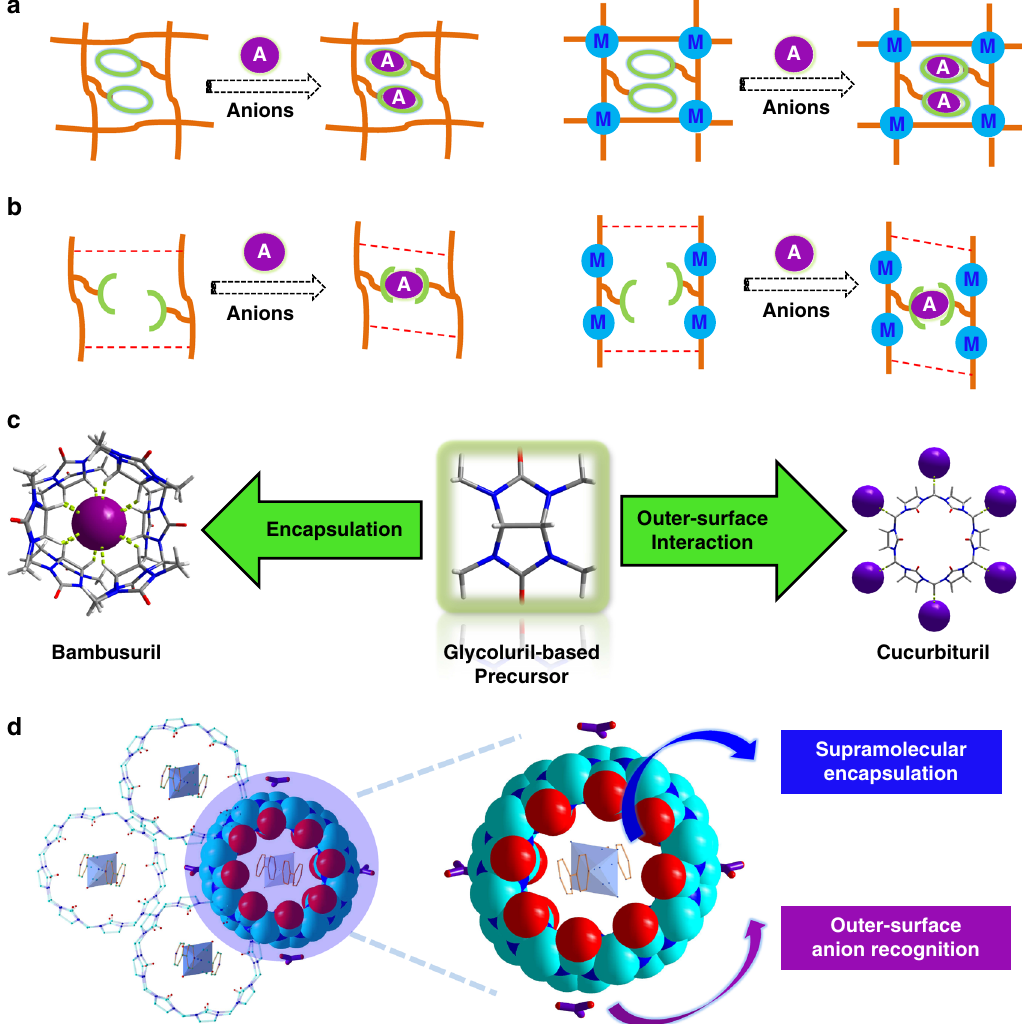
Fig. 1 Design strategies for introducing anion-adaptive capability to sorbent materials. a Direct modi fi cation of organic polymers or metal – organic sorbents with macrocyclic motifs bearing anion-recognition ability (orange lines: backbones of solid sorbents; green circles: anion receptors; purple balls marked as “ A ” : anions; blue balls marked as “ M ” : metal nodes). b Supramolecular assembly of smart polymers or metal – organic sorbents exhibiting anion-adaptive behaviors (orange lines: backbones of solid sorbents; green curves: anion-recognition sites; purple circles: anions; blue balls: metal nodes). c Glycoluril- based macrocyclic hosts for anion recognition through two different modes (purple balls: anions). d Dual roles of CB8 in accomplishing both the construction of a supramolecular network by encapsulation and providing outer-surface interaction sites for anion recognition: left, a full view of CB8-based supramolecular framework; right: enlarged diagram of CB8 showing its interactions with the surrounding components (red balls: O atoms; light-blue balls: C atom; dark blue balls: N